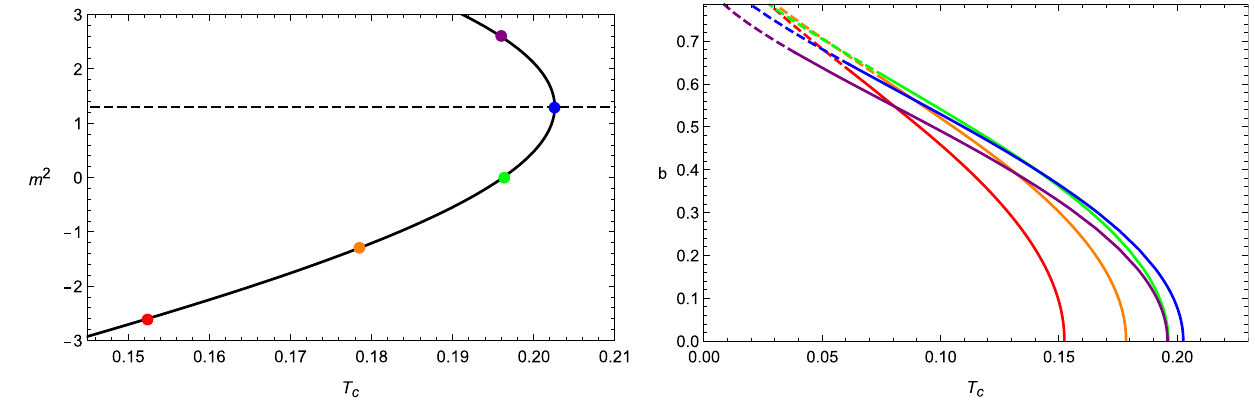
Fig. 4 m 2 − T c relation at probe limit (left plot) and b − T c relations (right plot) in the case m 2 p = 0. In the left plot, we show the T c − m 2 relationofthep-wave phasewhenbackreactioncanbeneglected,while in the right plot we show the b − T c curves for the critical points with